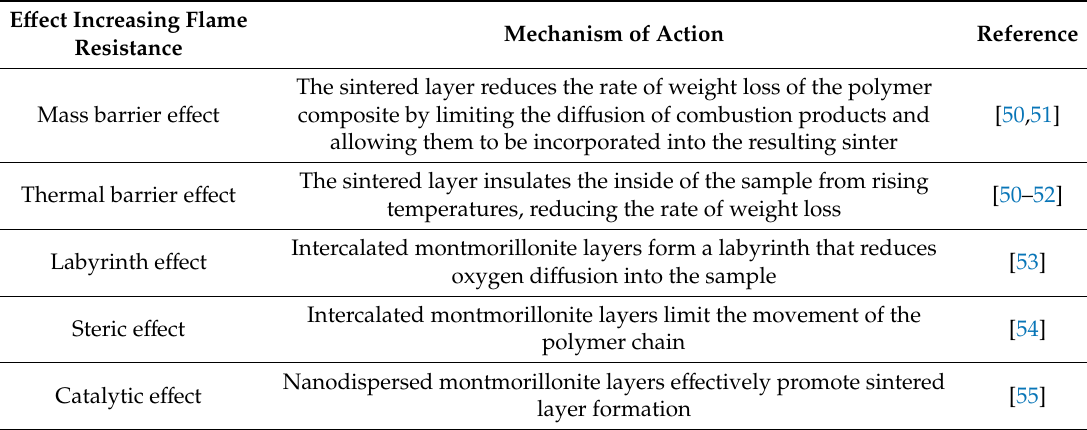
Table 1. Actions increasing flame resistance in polymer / montmorillonite